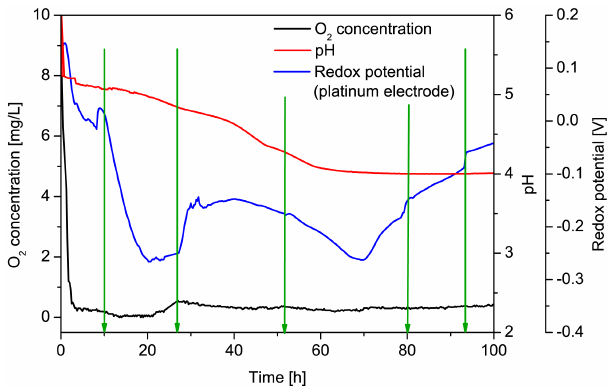
Figure 7. Course of the oxygen concentration, the pH value and the redox potential during a yeast fermentation over 100h in a labora- tory reactor; green arrows: movement of the sensor probe (volume: 150L; 294K).